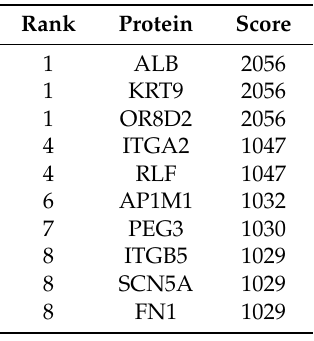
Table 3. Top 10 Hub nodes detected by Degree method.